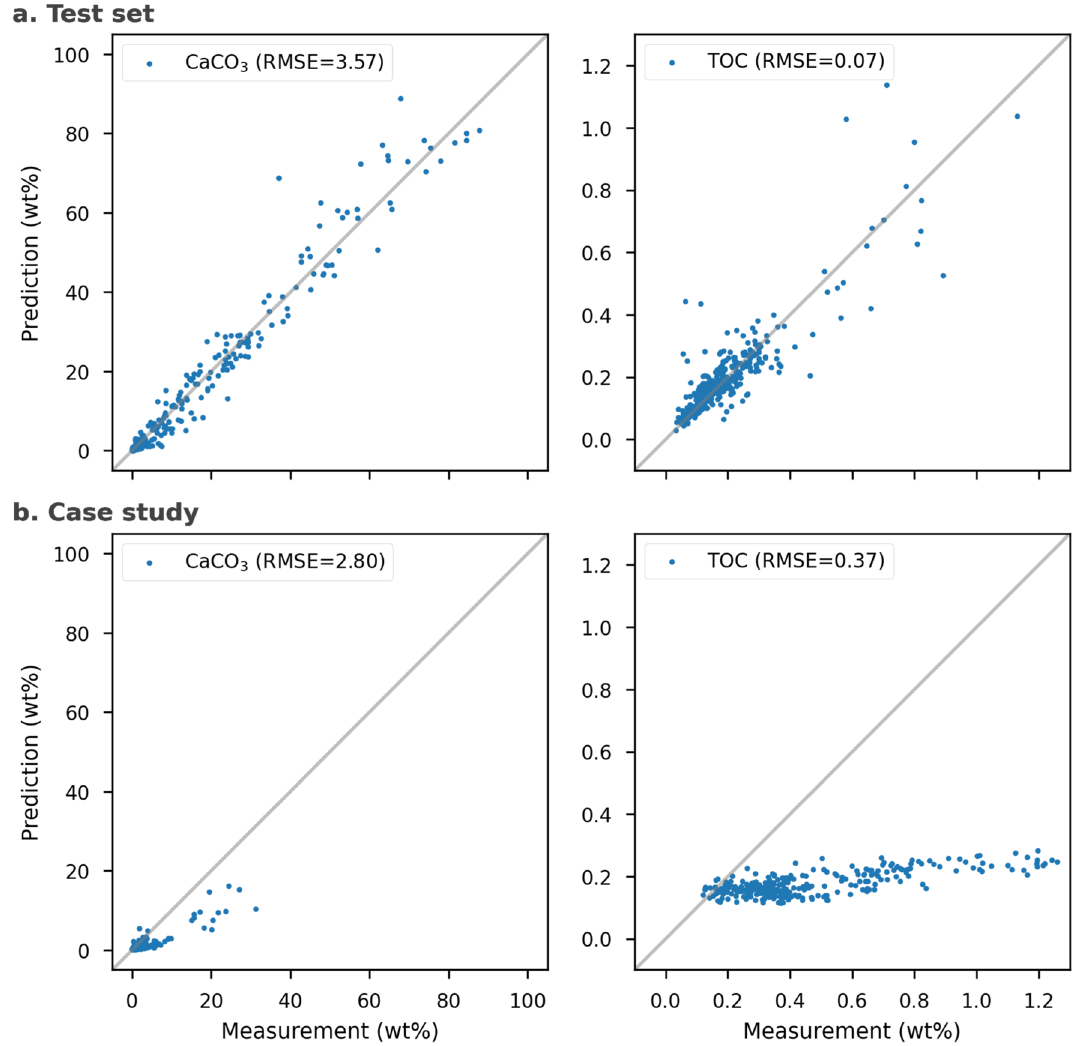
Figure 4. Measured versus predicted CaCO 3 (left panels) and TOC contents (right panels) in ( a ) the test set and ( b ) the case